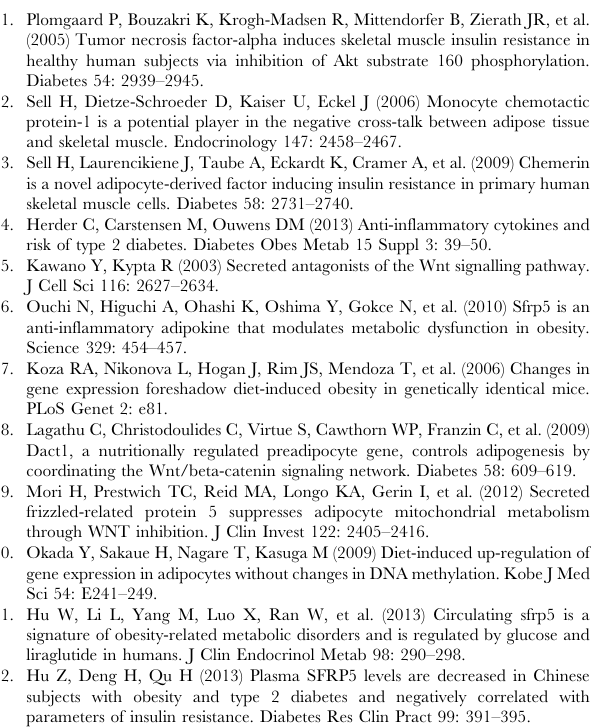
Figure S1 Effect of Wnt5a and Sfrp5 on myokine release from primary human skeletal muscle cells. Primary